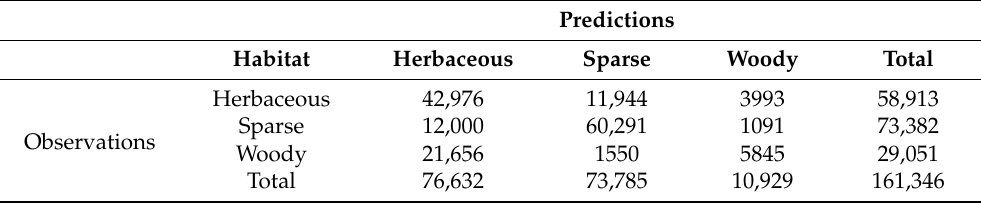
Table 5. Error matrix with observations along the rows and predictions along the columns. The sum of the rows represents the habitat observations, while the sum of the columns represents the model